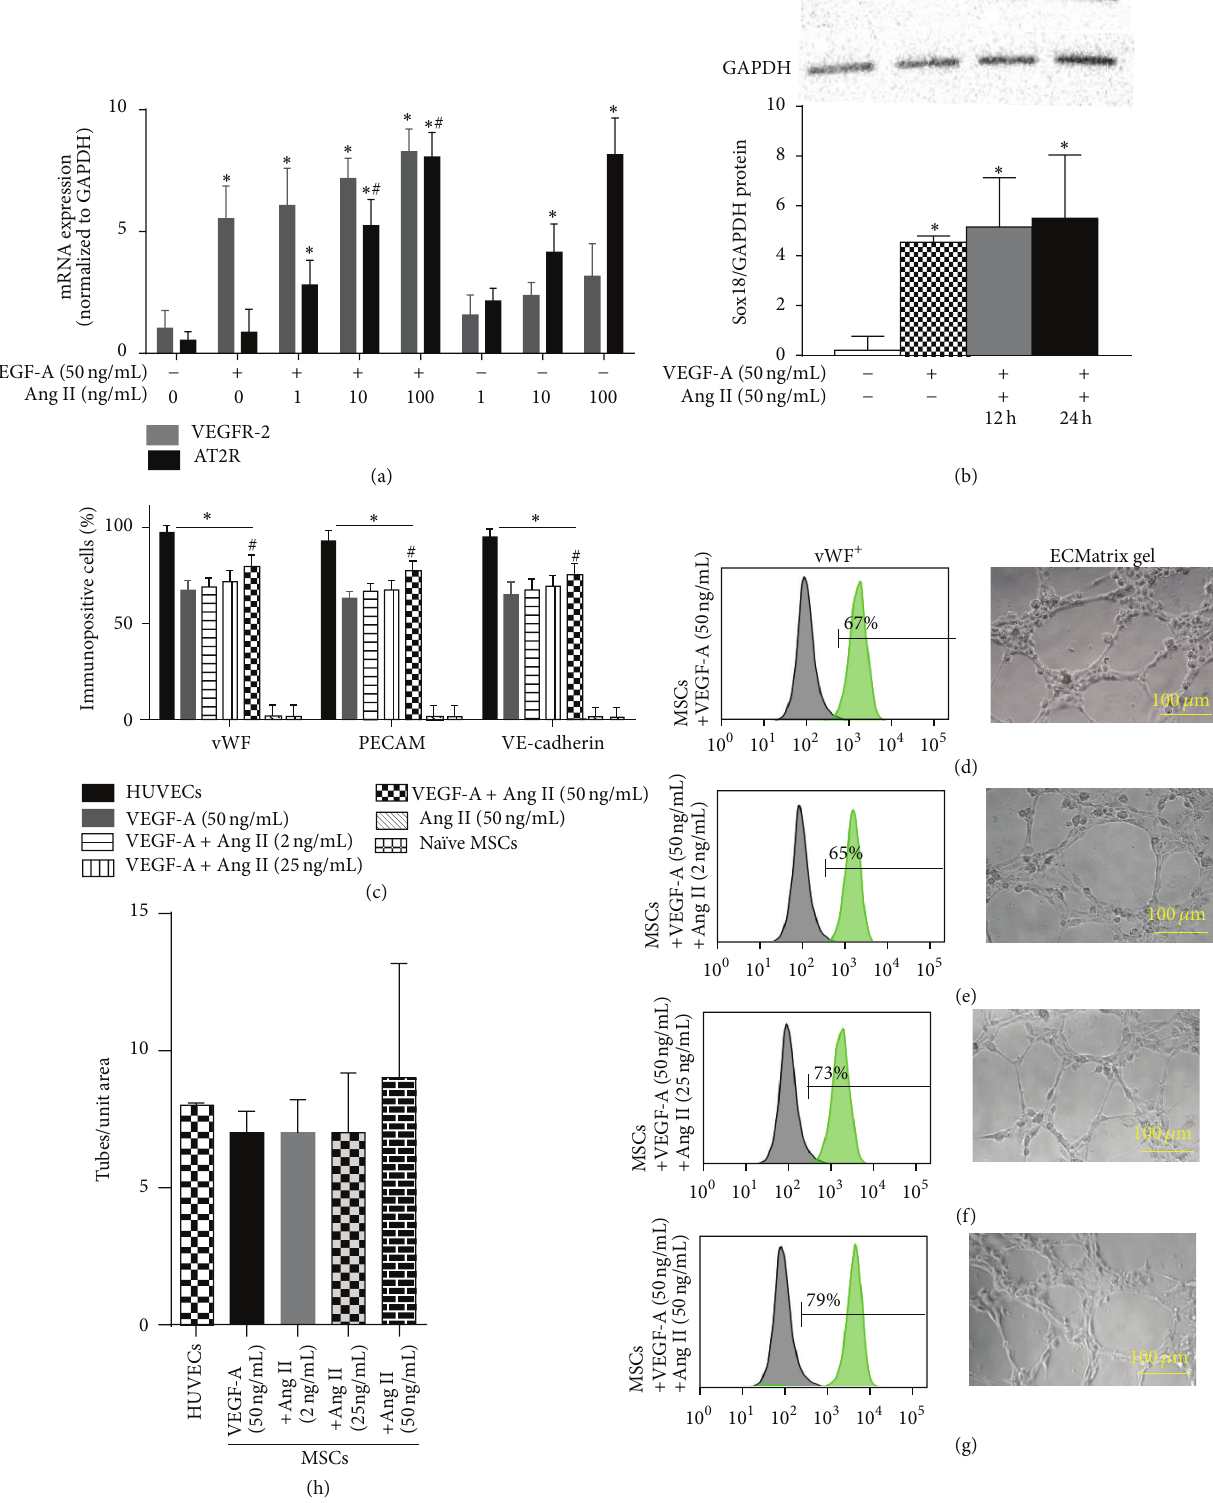
Figure5:AngIIpositivelyregulatesVEGF-A-mediatedECdifferentiation:theeffectofAngIIonVEGF-A-stimulateddifferentiationofMSCs into ECs was examined. AT2R and VEGFR-2 mRNA expression was analyzed by RT-PCR ( 𝑛 = 3 ) (a). Sox18 protein levels were measured by Western blot analysis ( 𝑛 = 3 ) (b). Expression of EC markers was determined by FACS analysis, and a representative grid is shown ( 𝑛 = 5-6) ((c)–(g)). Endothelial tube formation was examined using an angiogenesis assay ( 𝑛 = 3 ) ((d)–(h)). Experiments were performed with samples taken from independent BM-MSC cultures from separate microswine. HUVECs were excluded from statistical analyses. Data are shown as mean ± SD. ∗ 𝑝 < 0.05 versus na¨ıve MSCs and # 𝑝 < 0.05 MSCs treated with VEGF-A versus VEGF-A plus Ang II